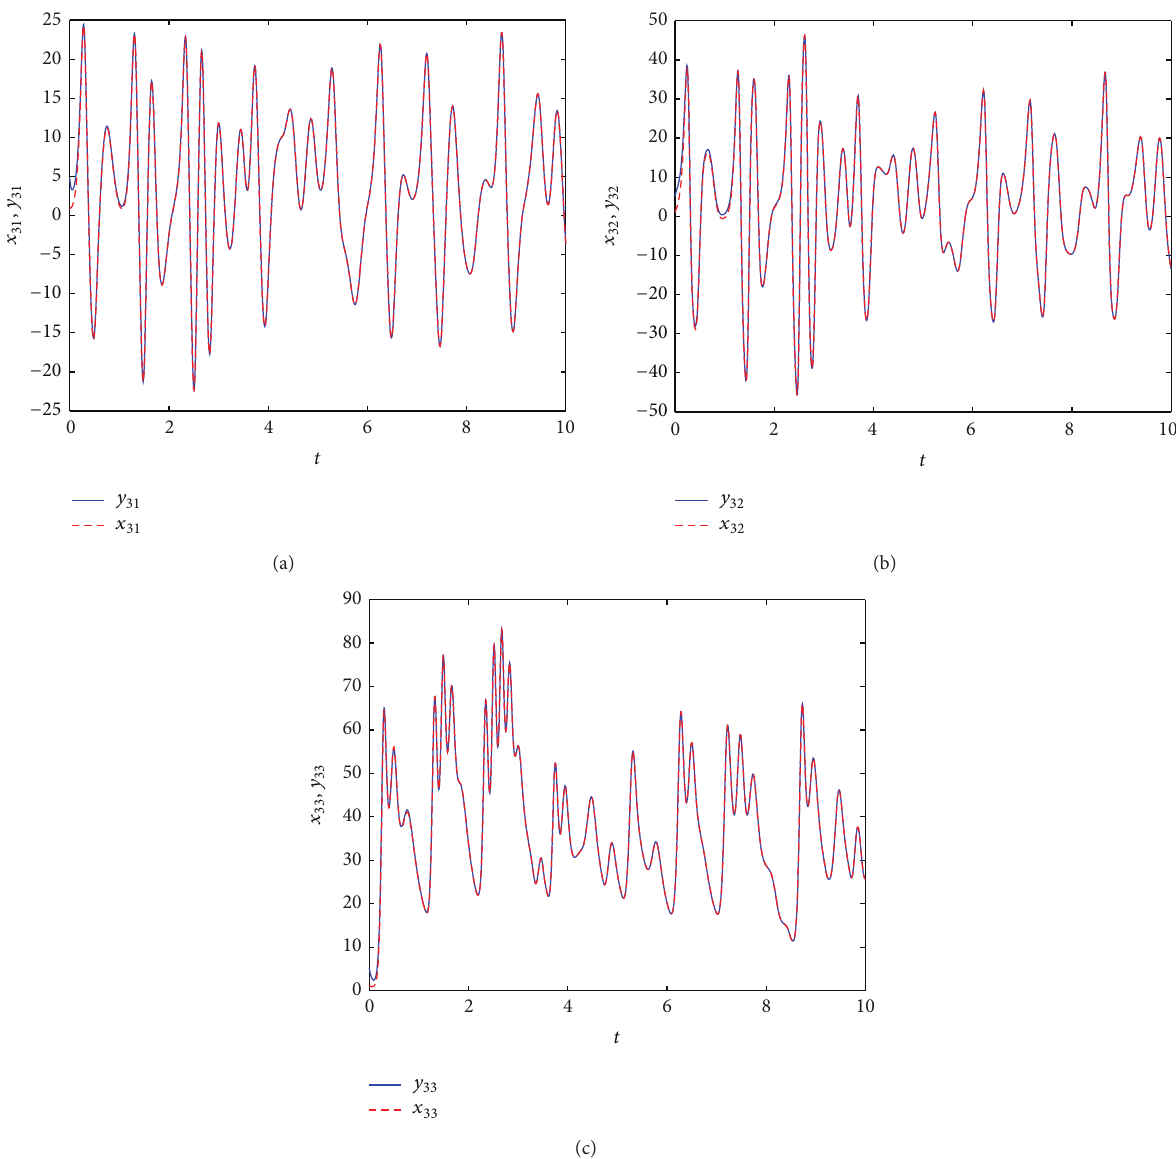
Figure 3: State subvariables for node 𝑖 = 3 between the drive and response coupled